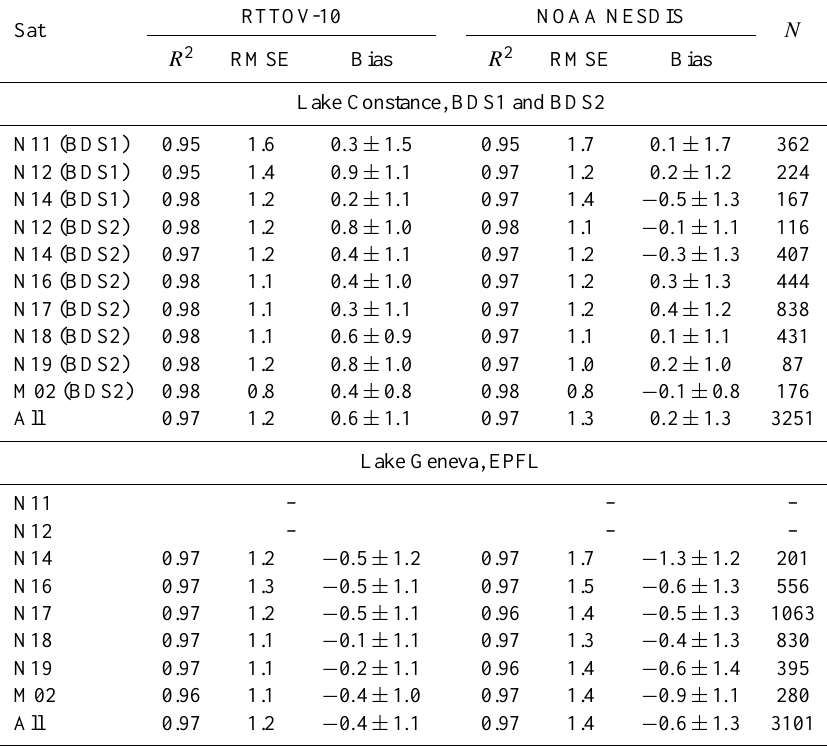
Table 5. Statistical parameters for all satellites at Lake Constance (BDS1 and BDS2) and Lake Geneva (EPFL) by using the regional LSWT- retrieval based on RTTOV-10 (RT-lswt) and NOAA NESDIS (NN-lswt; Oesch et al., 2005). Shown are the coefficient of determination as square of the correlation coefficient ( R 2 ); the root-mean-square error (RMSE); the bias as the mean temperature difference and standard deviation (cid:49)T ± σ (cid:49)T between OBS and LSWT; and the number of coincident observations. The comparison for NOAA-11 and -12 at EPFL is missing due to the lack of in situ data for that time. Sat